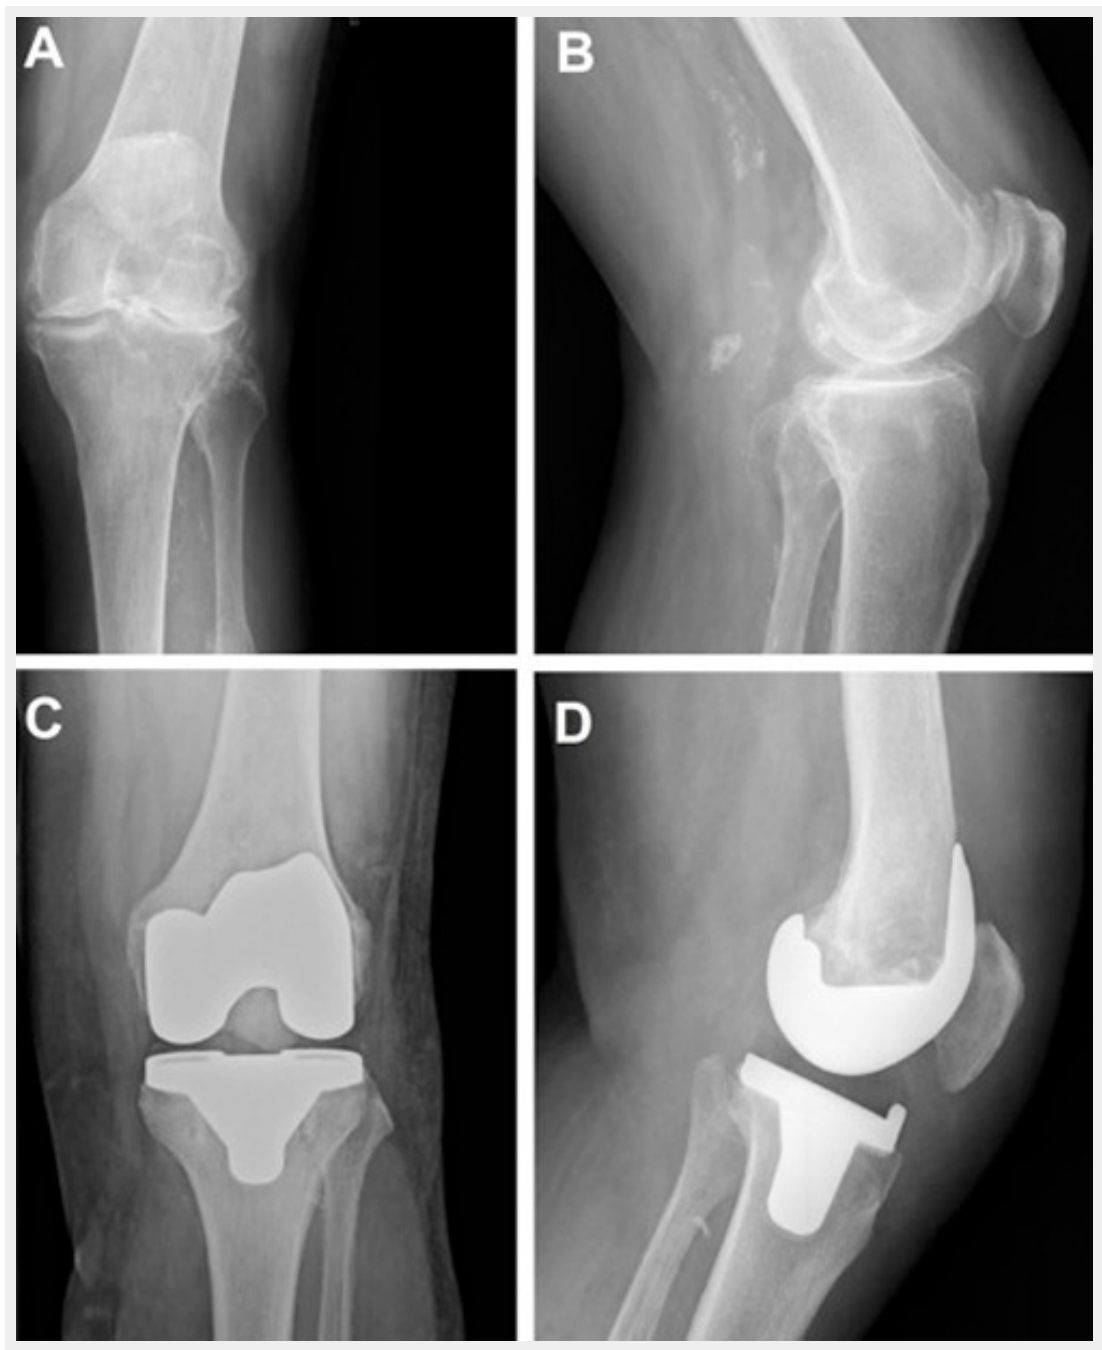
Figure 4 A. Anteroposterior X-ray of tricompartmental osteoarthritis. B. Lateral X-ray of tricompartmental osteoarthritis. C. Anteroposterior X-ray following total knee arthroplasty (TKA). D. Lateral X-ray following